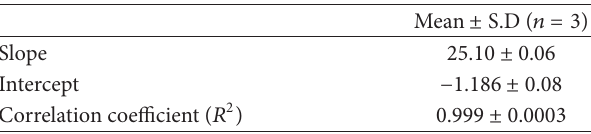
T 4: Results and regression analysis of linearity data of quetiap- ine